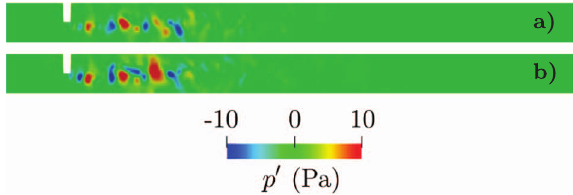
Figure 15. Instantaneous fi eld of pressure fl uctuation of C 1 of (a) the propagation simulation and of (b) the incompressible CFD simulation at t = 0.03